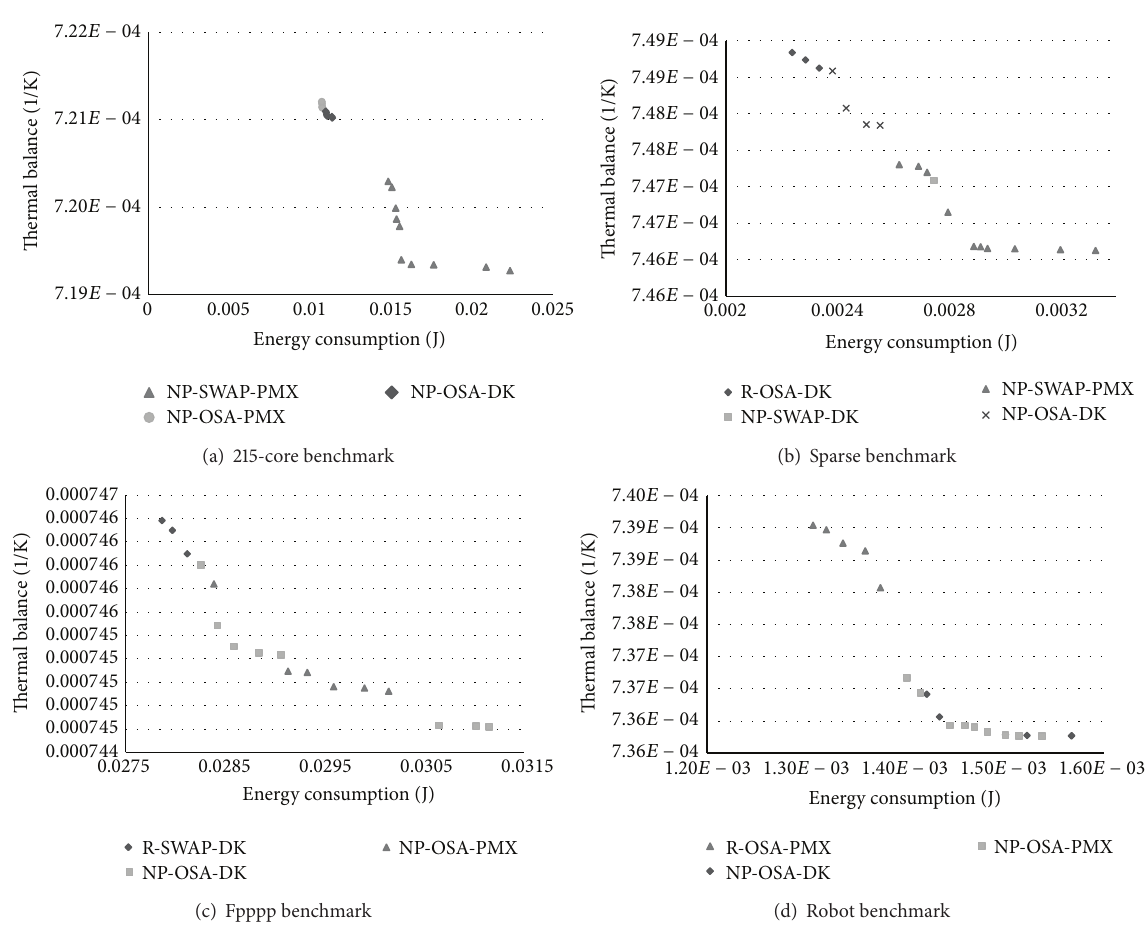
Figure 5: Combined Pareto fronts for all evaluated algorithms of different benchmarks.